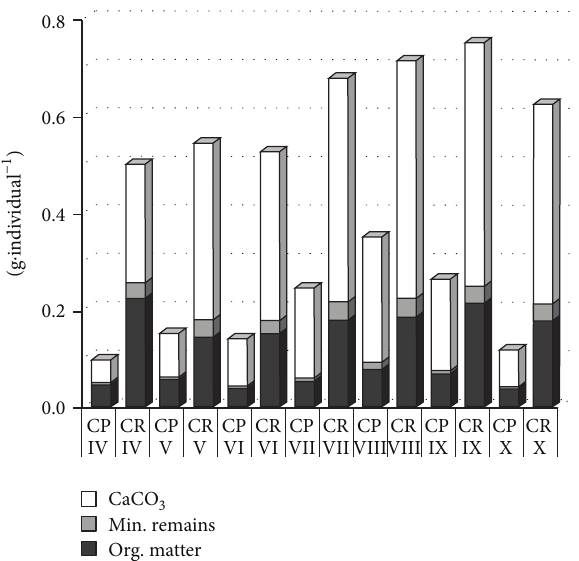
Figure 7: Month-to-month temporal variability of the dry weight structure of C. polyacantha (CP) and C. rudis (CR). The roman numbers mean the months of